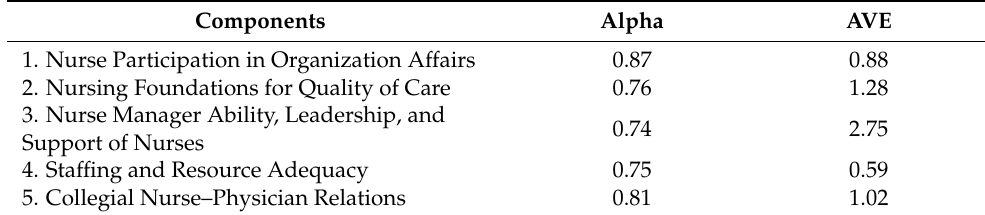
Table 3. Analysis of the construct validity of the PES-NWI in primary health care. AVE, average variance